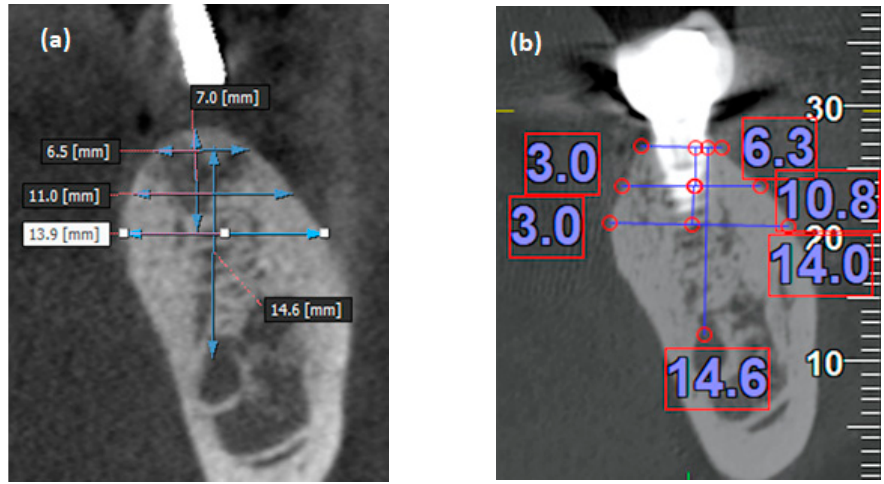
Figure 3. Cross-sectional view of CBCT images demonstrates the way to measure bone width ( a ) before (without implant) and ( b ) after the implant surgery (with implant).